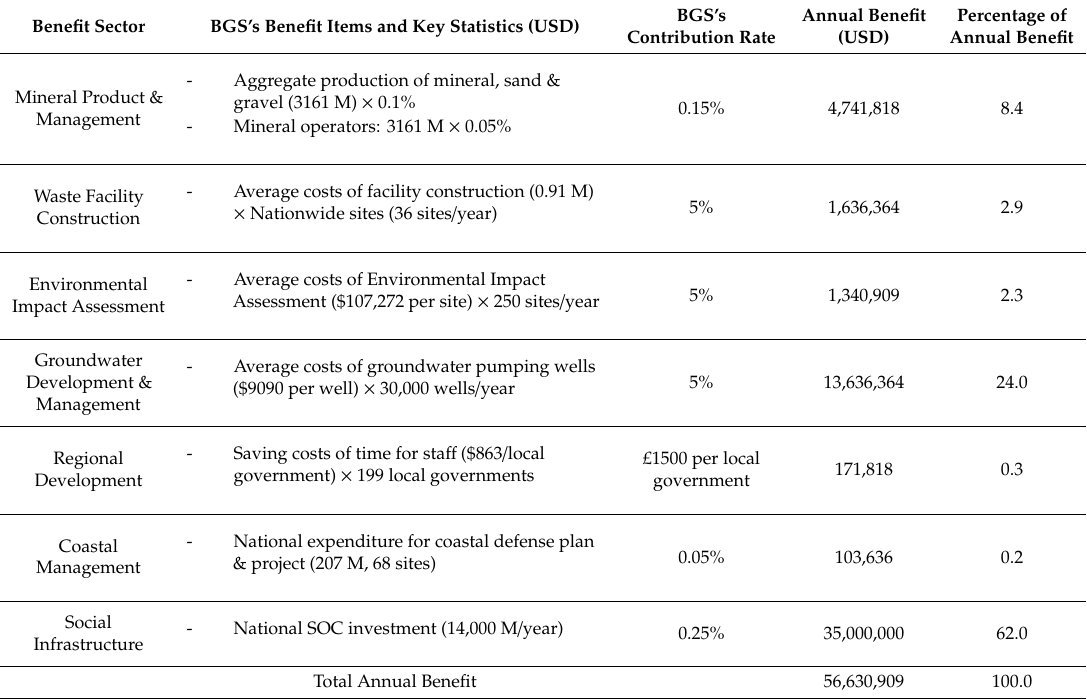
Table 7. Estimation of total annual benefits of geological information in South Korea